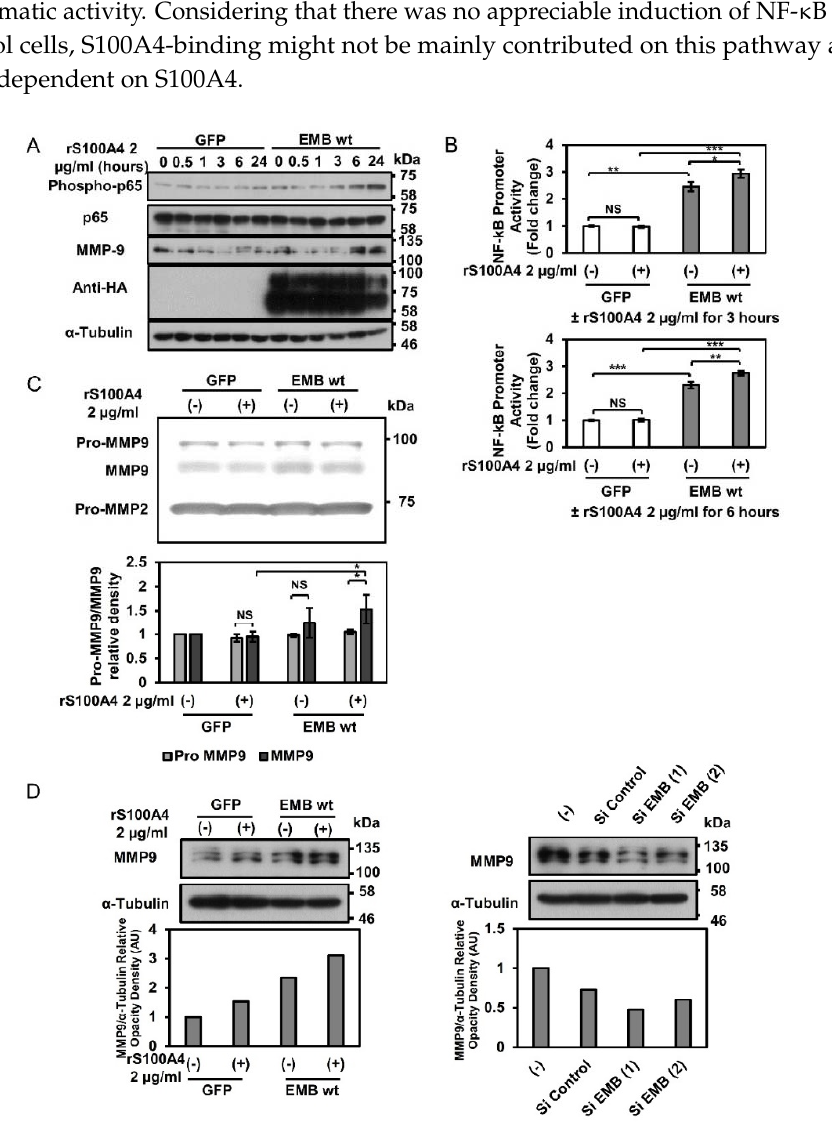
Figure 3. Embigin induces NF- κ B and MMP9 activation in prostate cancer cells. ( A ) DU145 cells transiently overexpressing GFP and embigin wild-type were stimulated with 2 µ g/mL of rS100A4 at the indicated times and evaluated by WB analysis. Binding of S100A4 to embigin induces NF- κ B